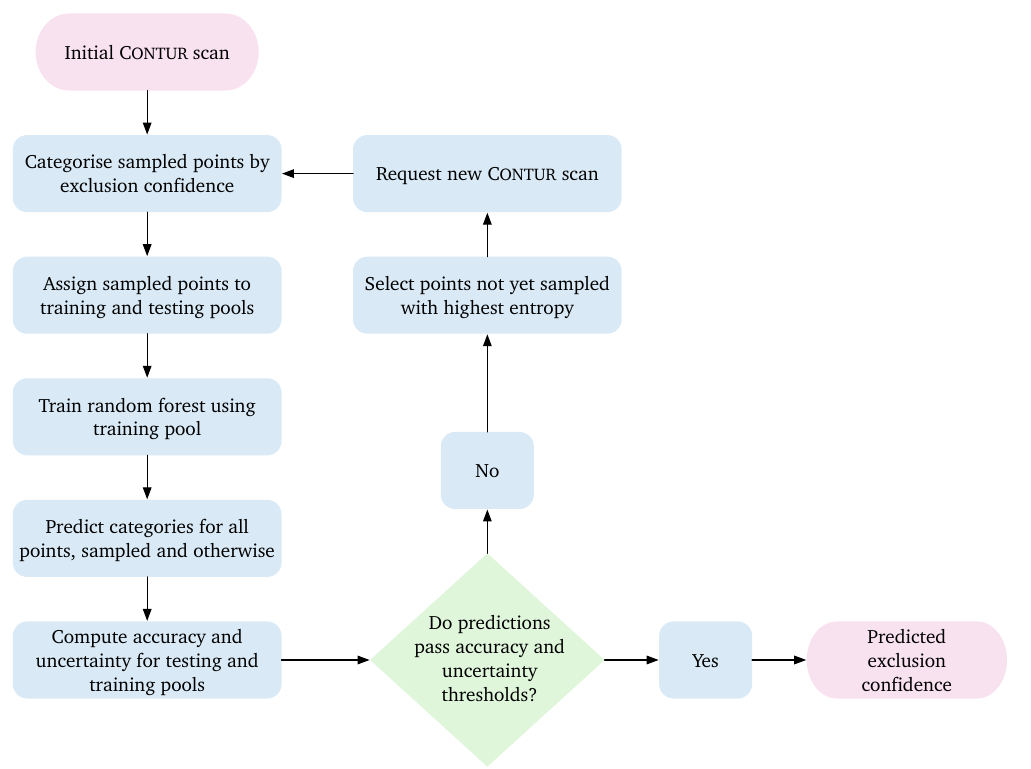
Figure 2: A detailed cartoon of the C ONTUR O RACLE workflow. From a grid of parameter points, an initial subset is chosen at random and evaluated using the standard C ONTUR programme. The C ONTUR results allow the points to be categorised into bins of CL exclusion. The points are then split randomly into training and testing pools: the training pool is used to train a random forest classifier to predict the CL